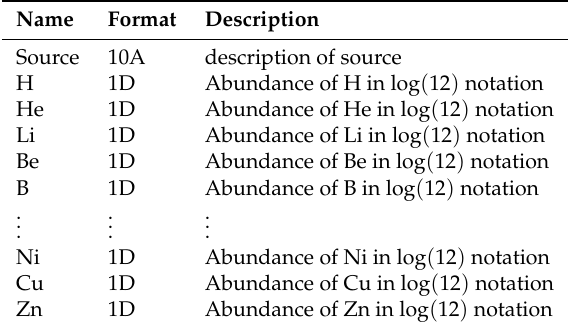
Table A9. APED abundance file definition. Each source refers to a different published data table. Descriptions matching them to publications can be found in the